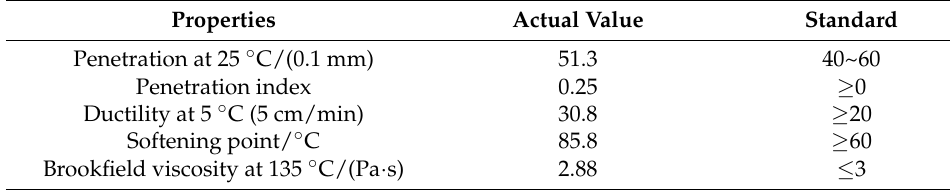
Table 1. Properties of 5% SBS-modified asphalt.